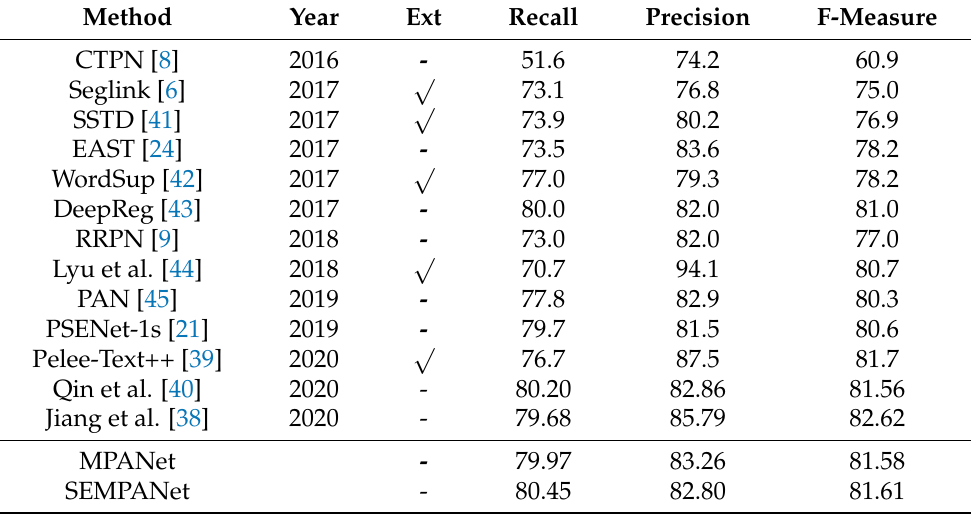
Table 4. The single-scale results on ICDAR2015. “Ext“ indicates external data. MPANet is a model without an SE